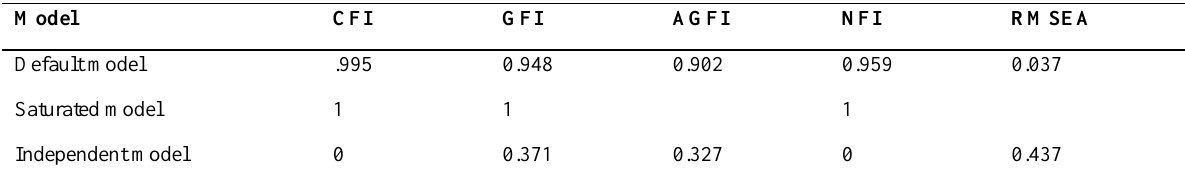
Table 3: Model- Fit Indices for the Influence of financial control on growth of private